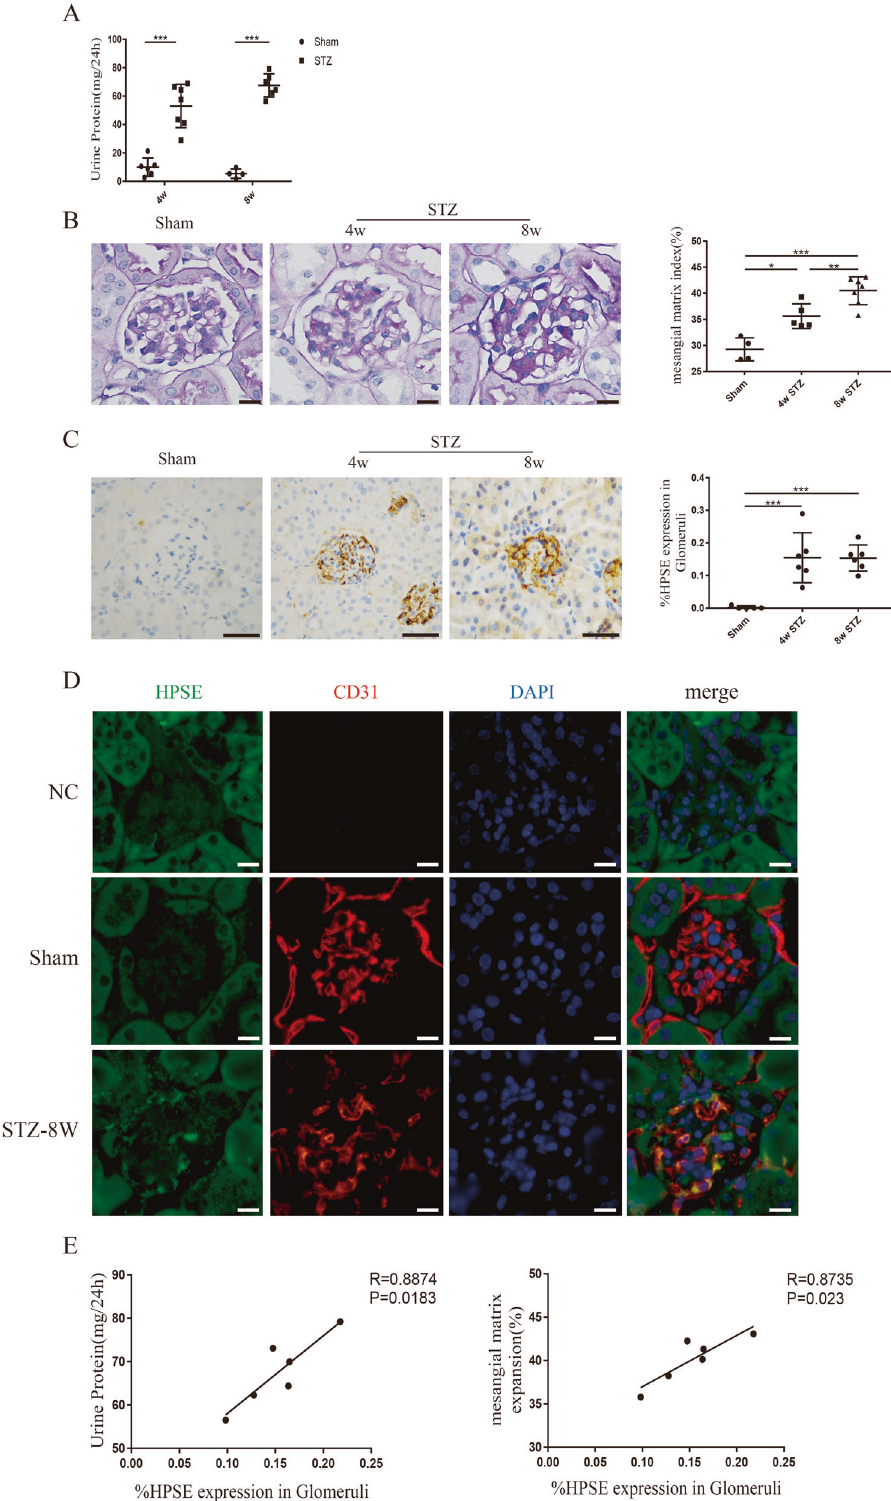
Fig. 1 HPSE expression was upregulated in GEnCs of STZ-induced diabetic mice. A Quantitation of 24 h urine protein showed signi fi cant proteinuria at 4w and 8w respectively after the onset of diabetes in STZ-induced diabetic mice. B PAS staining exhibited dramatic mesangial matrix expansion in STZ-induced diabetic mice. Scale bar = 10 μ m. C Immunohistochemical staining revealed the overexpressed HPSE in the glomeruli of diabetic mice. Scale bar = 50 μ m. D The count of double positive immuno fl uorescence staining for CD31 and HPSE was markedly high in diabetic mice, while it was negative in sham animals. Scale bar = 10 μ m. E HPSE expression was positively correlated with 24 h proteinuria ( R = 0.8874, P = 0.0183) and glomerular mesangial matrix expansion ( R = 0.8735, P = 0.023) respectively by Pearson correlation analysis. Each vertical bar represents the mean ± SD ( n = 4~7) analyzed by one-way ANOVA or two-way ANOVA followed by Tukey ’ s multiple comparisons test. * P < 0.05, ** P < 0.01, and *** P < 0.001. Cell Death Discovery (2022)